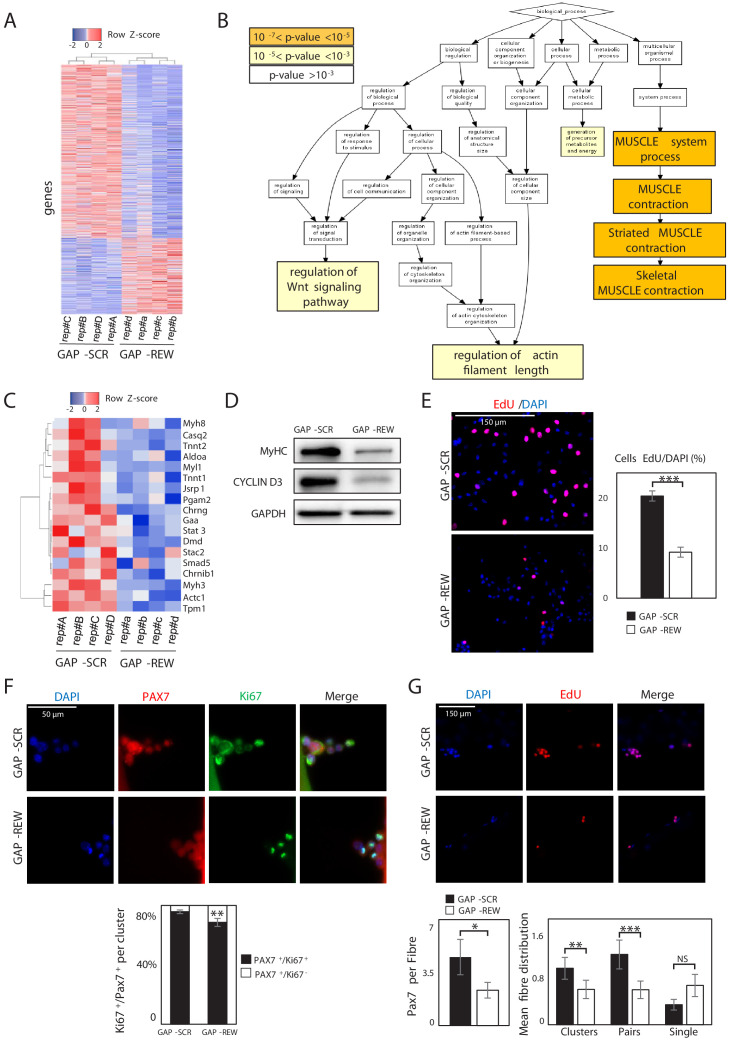
Lnc-Rewind regulates muscle system processes and MuSC expansion.(A) Heatmap representing hierarchical clustering performed on the final list of genes differentially expressed in MuSC-derived myoblasts upon Lnc-Rewind depletion (p-value threshold<0.05; see also Figure 2—source data 1). The analysis was performed using the Heatmapper webserver tool (Babicki et al., 2016). For each gene, expression levels are expressed as Z-score values. (B) Gene Ontology (GO) enrichment analysis performed by GORILLA (Eden et al., 2009) in Biological process for genes differentially expressed upon Lnc-Rewind depletion in MuSC-derived myoblasts. (C) Heatmap representing hierarchical clustering performed on DEGs belonging to the Skeletal Muscle contraction GO category (GO:0003009). The analysis was performed using the Heatmapper webserver tool (Babicki et al., 2016). For each gene, expression levels are expressed as Z-score values. (D) Western blot analysis performed on protein extracts from MuSC-derived myoblasts treated with GAP-SCR or GAP-REW. GAPDH protein was used as endogenous control. (E) Representative images of MuSC-derived myoblasts treated with GAP-SCR and GAP-REW and incubated with EdU (red). Nuclei were visualized with DAPI (blue). Histogram shows the percentage of EdU-positive cells on the total of DAPI-positive cells. Data are graphed as mean ± SEM; n = 6 mice. (F) Representative images of single muscle fibres from WT mice treated with GAP-SCR or GAP-REW and stained for Pax7 (red) and Ki67 (green). Nuclei were visualized with DAPI (blue); histogram shows the percentage of Pax7+/Ki67− cells on the total of Pax7+/Ki67+ cells per cluster. Data represent the mean ± SEM of 40 clusters per condition; n = 5 mice. (G) Representative images of single muscle fibres from WT mice treated with GAP-SCR or GAP-REW and incubated for 24 hr with EdU (red). Nuclei were visualized with DAPI (blue); left histogram shows the number of Pax7+ cells per fibre (50 fibres per condition; n = 5 mice). Right histograms represent the mean of clusters (nuclei [n], n > 2), pairs (n = 2), and single cells Pax7+ (n = 1) per fibre. Data represent the mean ± SEM of 80 fibres per condition; n = 5 mice. Data information: *p<0.05, **p<0.01, ***p<0.001, unpaired Student’s t-test.Figure 2—source data 1.List of the differentially expressed genes (DEGs) between GAP-SCR and GAP-REW transfected MuSCs.Figure 2—source data 2.Source data for Figure 2.